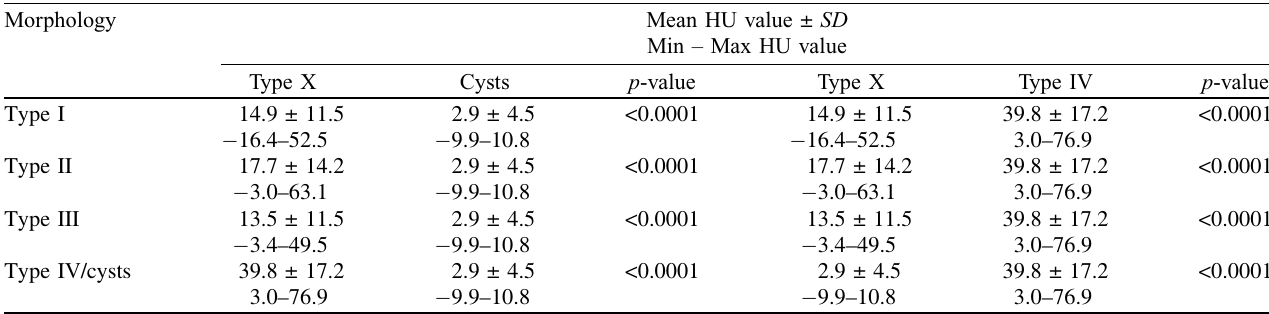
Table 3. Difference in the HU values of primary morphological types I – IV compared with cysts, as well as of primary morphological types I – III and cysts compared with type IV.